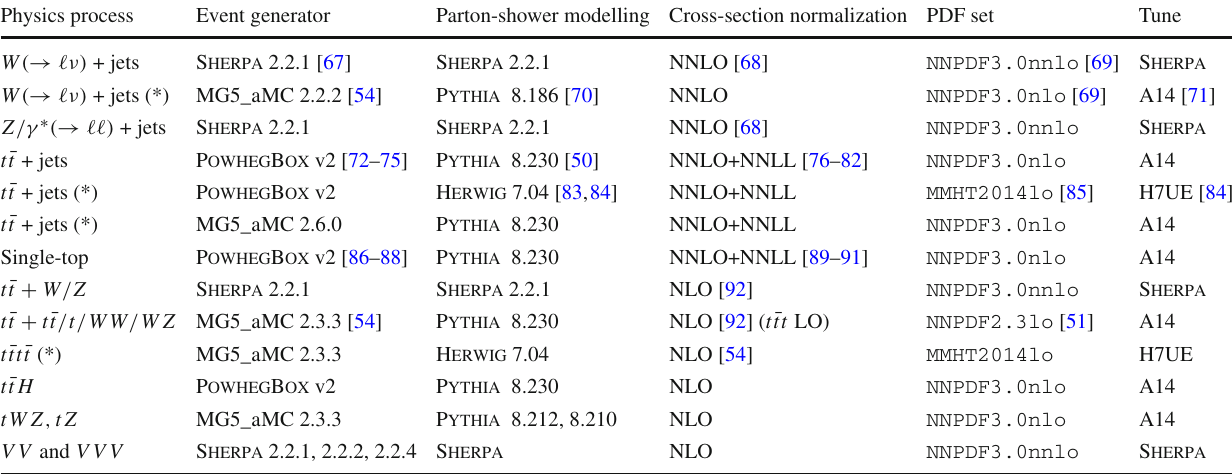
Table2 Simulatedbackgroundeventsamples:thecorrespondingevent ground estimation method or to assess systematic uncertainties in the generator, parton-shower modelling, cross-section normalization, PDF modelling. The abbreviation MG5 _a MC is used to label the Mad- Graph5 _a MC@NLO generator. Samples produced with Sherpa use set and underlying-event parameter tune are shown. The samples marked with (*) are alternative samples used to validate the back- the default set of tuned parameters of the generator Event generator Parton-shower modelling Cross-section normalization PDF